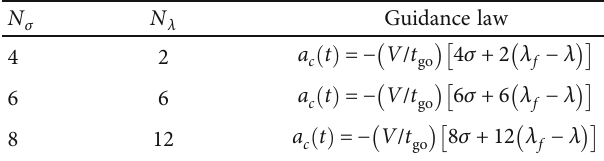
Table 2: Guidance laws with di ff erent guidance coe ffi cients.